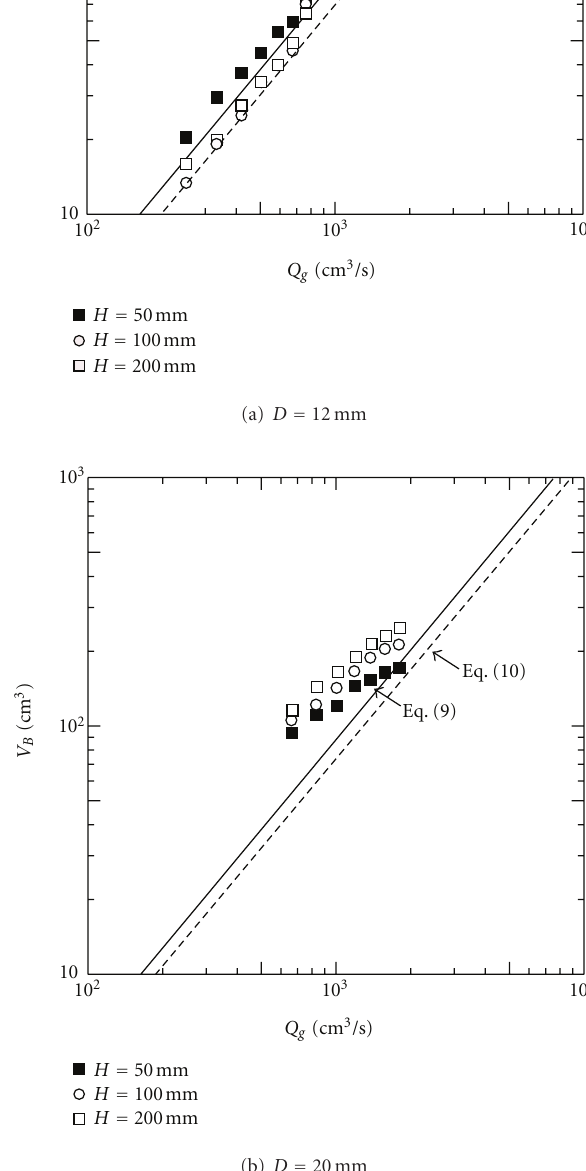
Figure 15: Relationship between dominant frequency of bubble formation and dimensionless air superficial velocity.